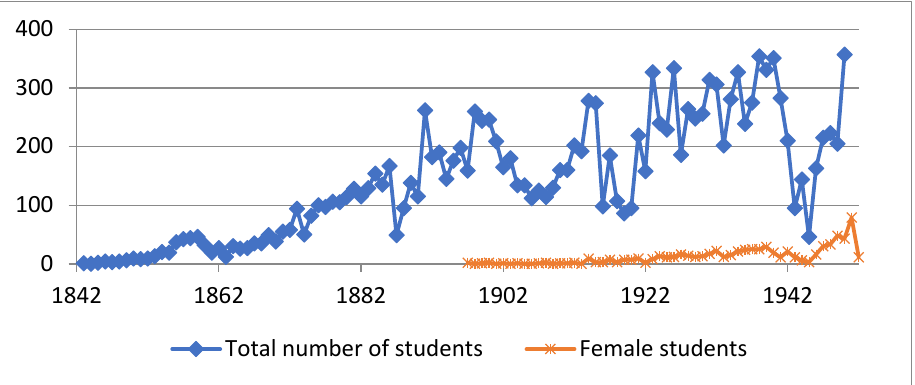
Figure 2. Number of graduates from the School of Medicine of the University of Athens, 1842–1952. Source: Boukis, D. 22 and Directory of graduates from the School of Medicine, Historical Archive Secretariat of School of Medicine,